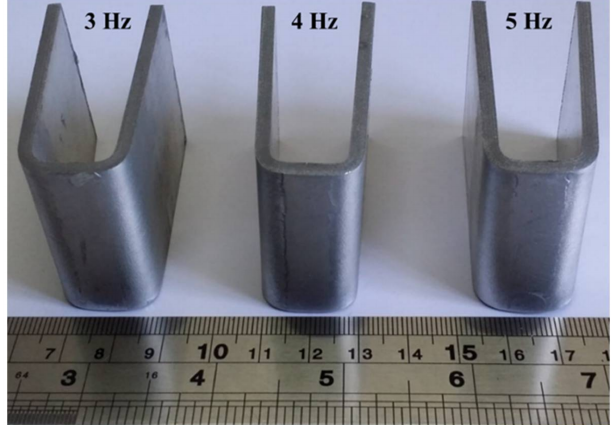
Figure 12. Macroscopic pictures of the bended samples.